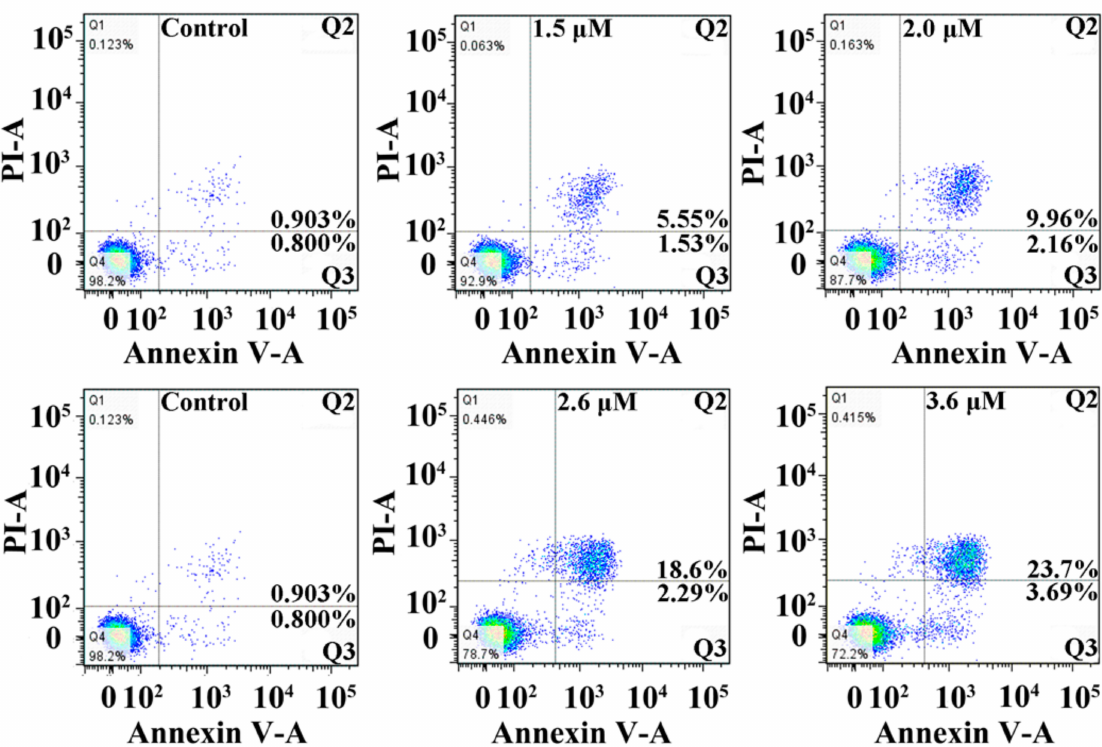
Figure 5. The Annexin V/propidium iodide assay and flow cytometry assay of MGC80-3 cells treated with Cu(II) complex 1 (1.5, 2.0, 2.6 and 3.6 µ